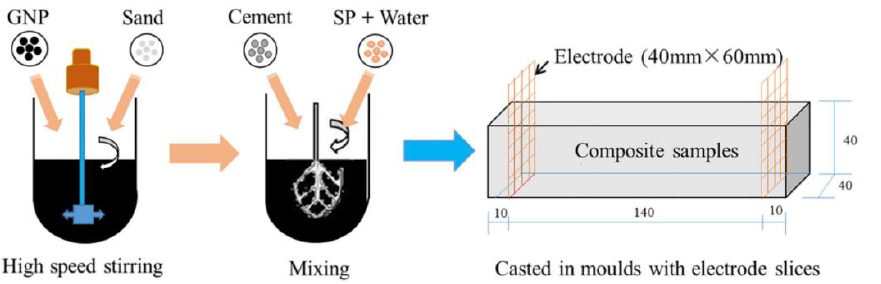
Figure 7. Dry-mix dispersion method to prepare GNP reinforced CCMs. Reprinted from Ref. [72]. Copyright 2018 Elsevier.